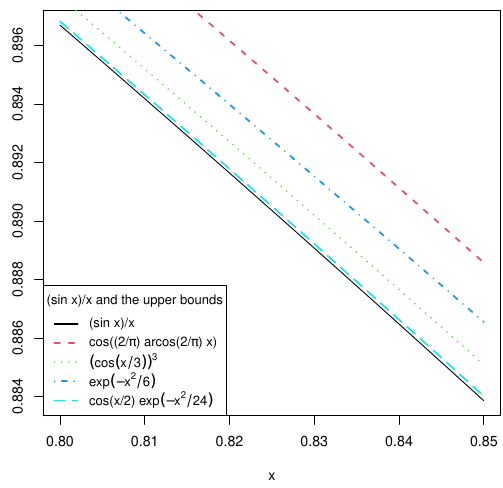
Figure 2. Visual comparison of upper bounds for (sin x ) /x with x ∈ [0 . 8 , 0 . 85] ; the obtained upper bound is in light blue